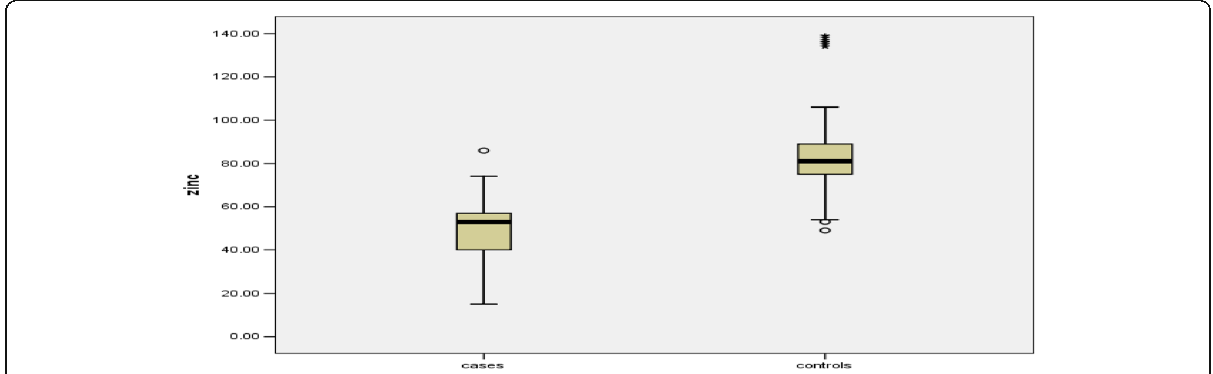
Fig. 4 Comparison between mean value of zinc serum level in patients with carbamazepine intake and control